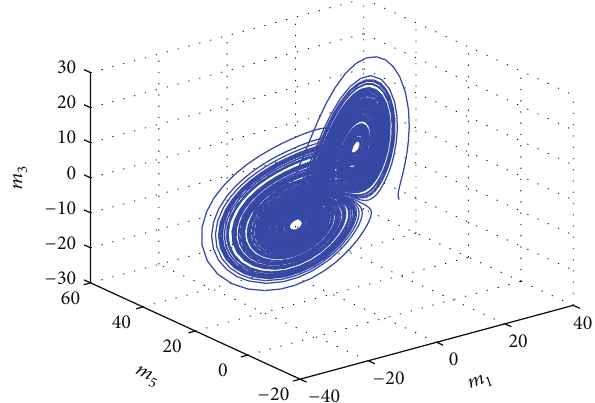
Figure 1: Chaotic attractor of complex L¨u system (𝑎 1 , 𝑎 2 , 𝑎 3 ) = (40, 22, 5)